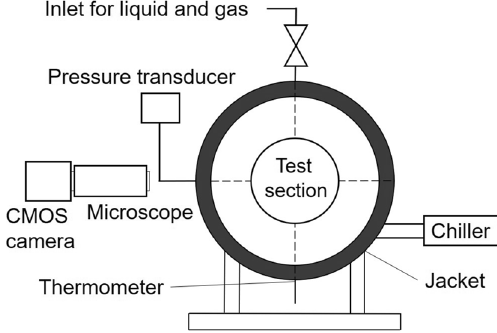
Figure 7. Schematic diagram of the experimental apparatus.